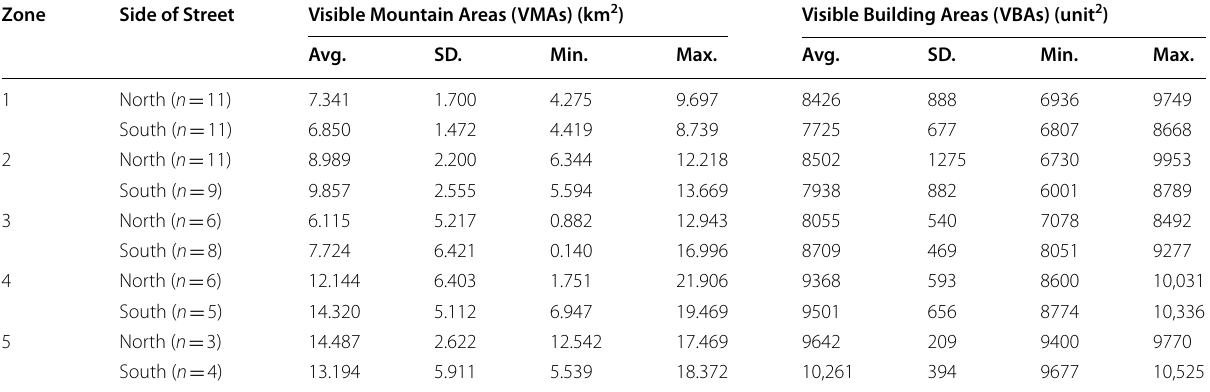
n number of viewpoints